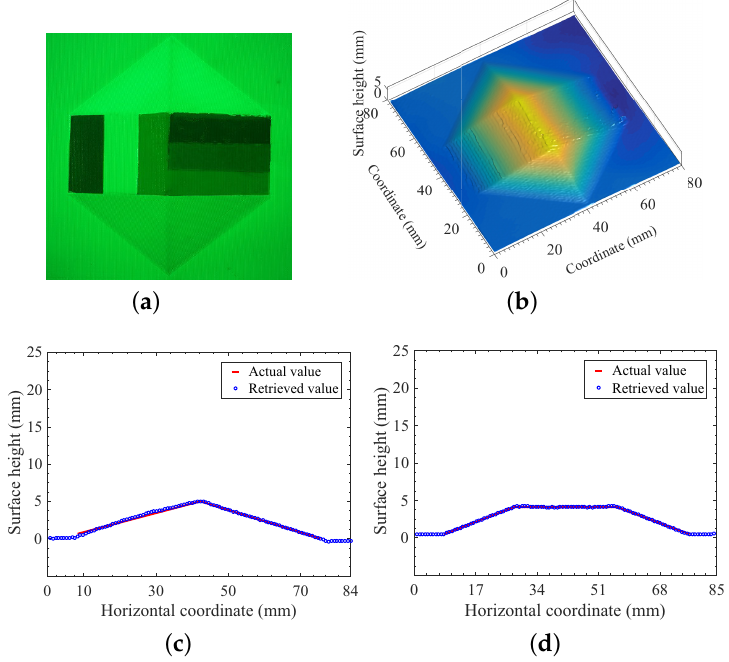
Figure 15. Reconstruction of 3D-printed color object with optical filtering as background illuminance E = 5600 Lux . ( a ) image of the illuminated object; ( b ) retrieval using the image of ( a ); ( c ) comparing the retrieved height distribution on the cross section perpendicular to the ridge with the actual values; ( d ) comparing the retrieved height distribution on the cross section parallel to the ridge the ridge with the actual